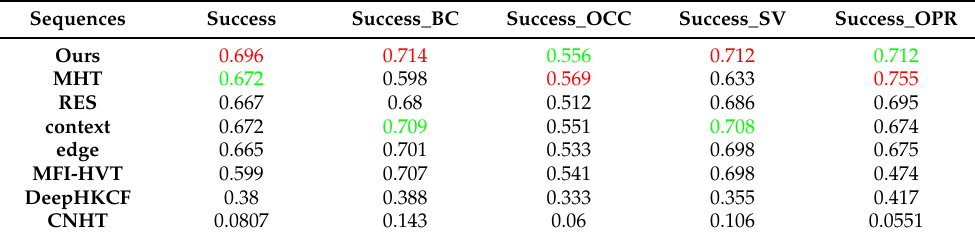
Table 3. The success rate of each tracker, with a suffix indicating the challenge faced, and the top two results are highlighted in red and green respectively. The result has three significant decimal places.